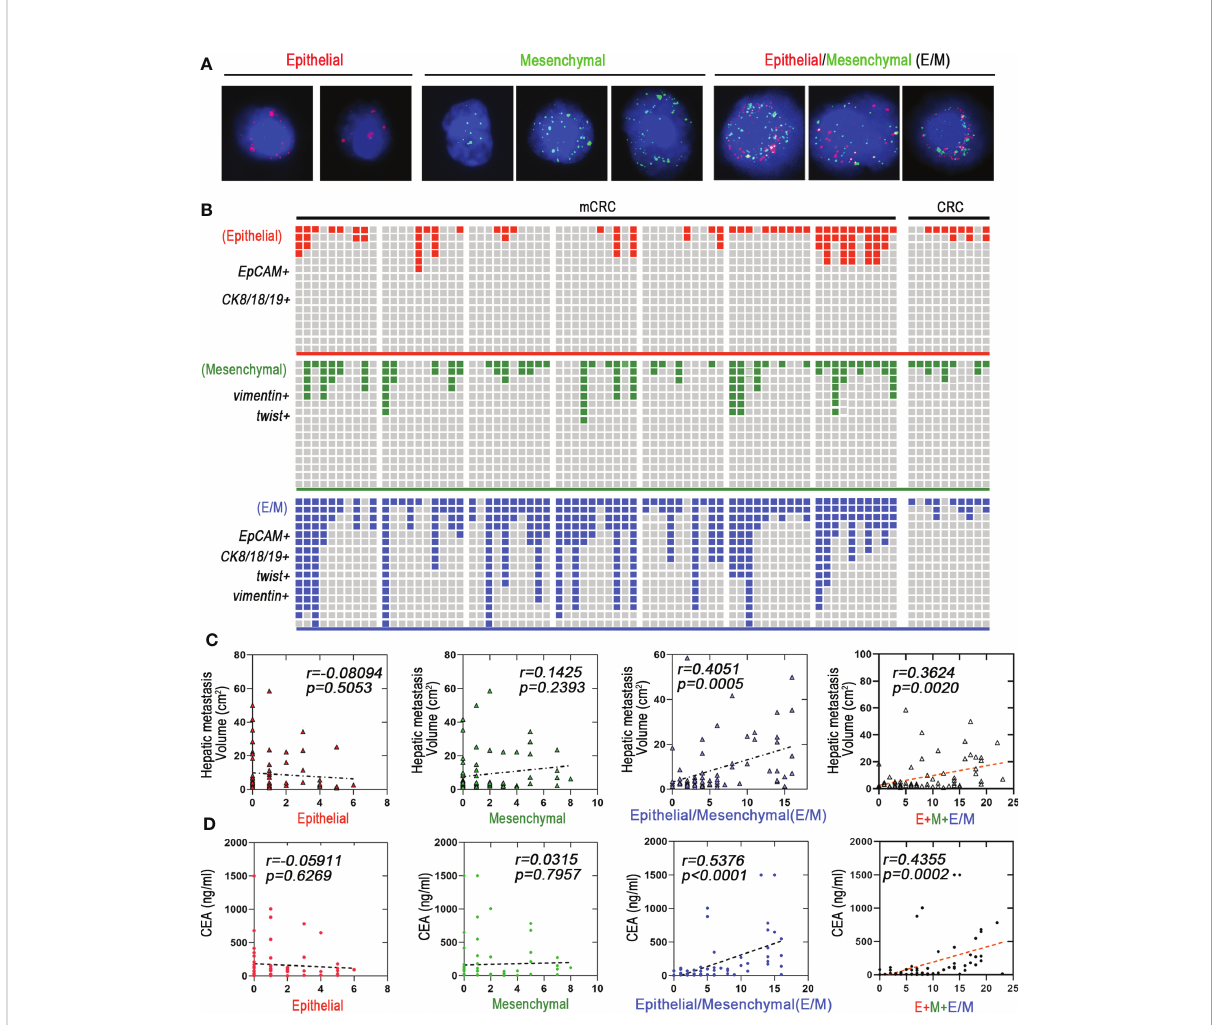
FIGURE 2 Hybrid epithelial/mesenchymal phenotype (E/M) CTCs contributes to liver metastasis of mCRC. (A) CTCs were detected by Canpatrol ® system (red: EpCAM, CK8, CK18, and CK19, green: vimentin and twist). DAPI (4 ′ ,6-diamidino-2-phenylindole). (B) Shown are proportions of E, M, and E/ M phenotype CTCs in individual mCRC patients (n=70) and CRC patients (n=30). The x-axis represents each patient. The Y-axis represents the overall fl uorescence intensity for each EMT type in each patient(Fluorescence intensity of Canpatrol system uses EpCAM, CK8, CK18 and CK19 to mark E-type CTC, twist and vimentin to mark M-type CTC, and EpCAM, CK8, CK18, CK19, twist and vimentin to mark E/M-type CTC. In different types of EMT subtypes of each patient, red, blue and green squares represent the proportion of fl uorescence intensity of the patient in all patients). (C) E, M, and E/M phenotype CTCs to predict the liver metastatic tumor volume are depicted as a linear regression model. P value are indicated. (D) E, M, and E/M phenotype CTCs to predict the carcino-embryonic antigen (CEA) are depicted as a linear regression model. P value are